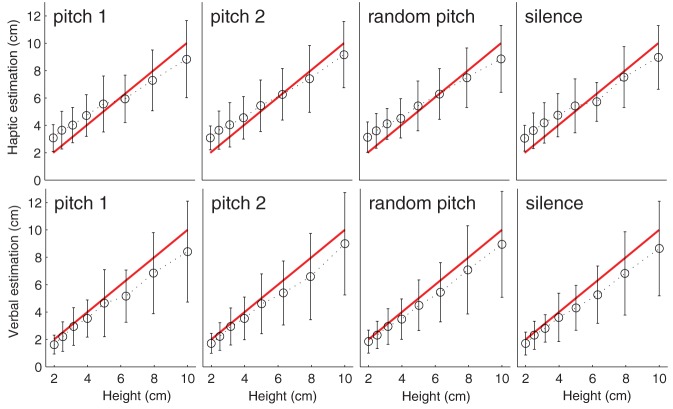
Height estimations. Mean and standard deviation (error-bars) of haptic (first row) and verbal (second row) estimations for each of the four feedback conditions and eight heights. Red lines denote actual heights of the step-riser.